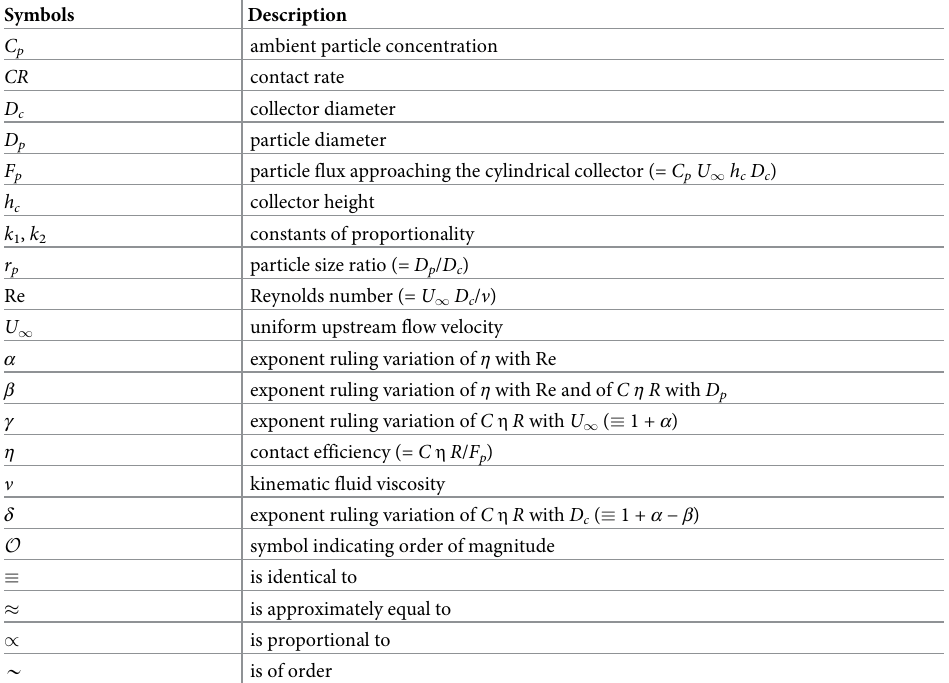
Table 1. List of